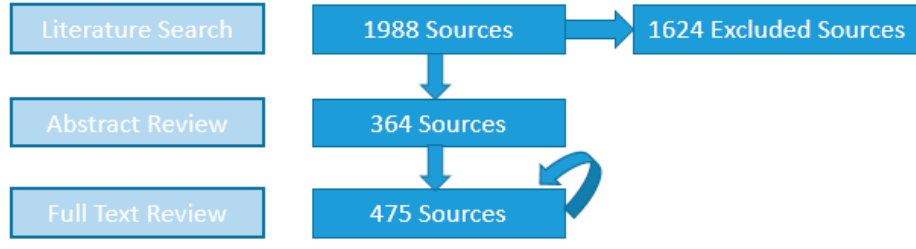
Figure 1. Source counts obtained after each of the three major stages of literature review (circular arrow represents addition of new full text-reviewed sources from reference lists of prior full text-reviewed sources).